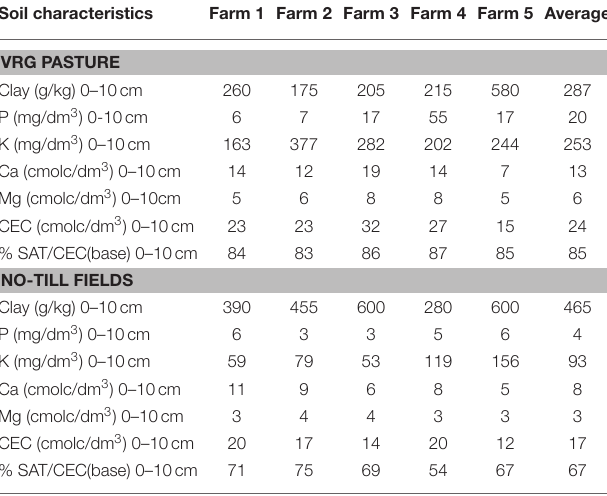
TABLE 2 | Soil characteristics on each of the five properties studied for carbon stock in 2014 for Voisin’s Rational Grazing (VRG) and No-tillage crop system (NT). Soil